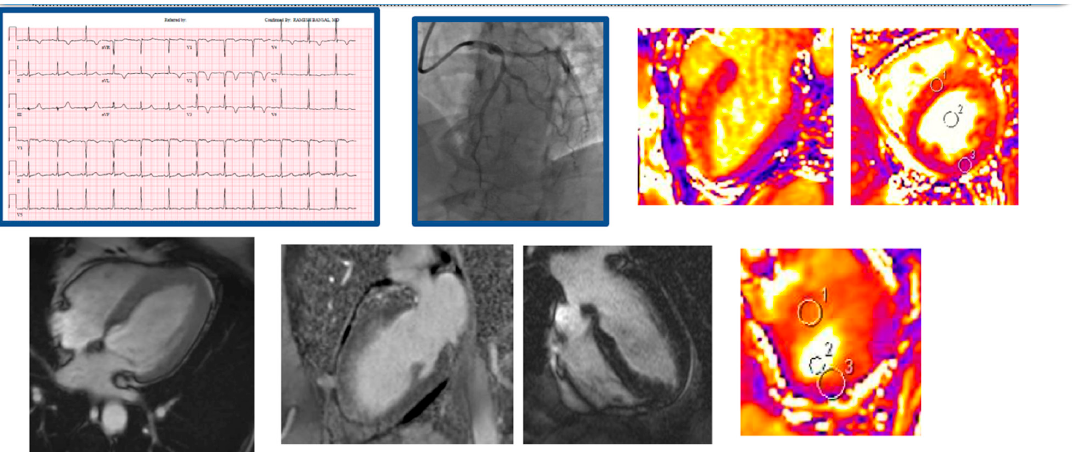
Figure 3. Demonstrative case of a myocardial infarction and acute LAD vasospasm. A 52 yo female with recurrent admissions with chest pain presented anterior STEMI on EKG, troponin I = 0.87, on cardiac catheterization found to have 50% LAD lesion responsive to nitroglycerine, LVEF was found to be 25% on initial TTE. Areas 1–3 suggest areas of interest to measure mapping. The presence of myocardial edema in the LAD territory without any obvious late gadolinium enhancement, suggested myocardial stunning.